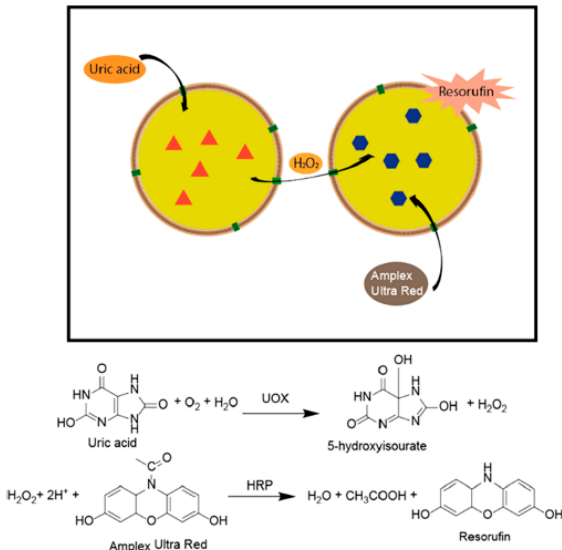
Figure 3. The schematic representation of catalytic nanocompartments [outer membrane protein F (OmpF), green rectangle] working in tandem, and a detailed cascade reaction mediated by a combination of uricase (UOX, red triangles) and horseradish peroxidase (HRP, blue hexagons). The oxidation of uric acid results in the formation of 5-hydroxyisourate and hydrogen peroxide. The latter is a co-substrate for HRP in the presence of substrate Amplex Ultra Red, AR. The final product, resorufin, can be monitored by fluorescence spectroscopy (reproduced with permission from [73], Copyright 2018, American Chemical Society).